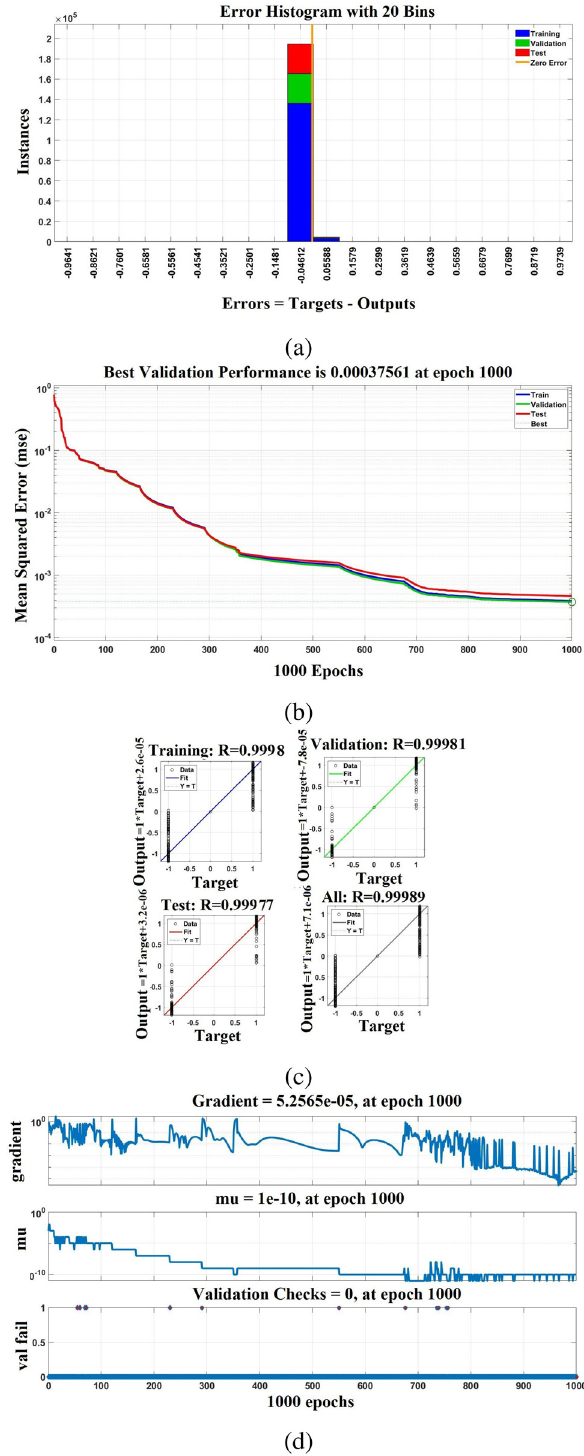
Figure 13: Proposed controller training on q - axis during LVRT cap - ability of DFIG system during grid fault: ( a ) histogram, ( b ) perfor - mance, ( c ) regression, and ( d )